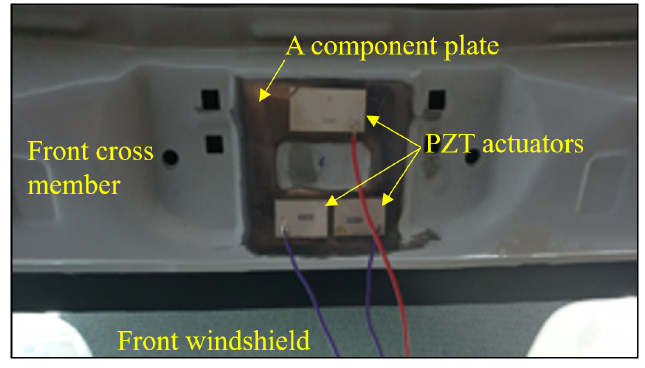
Figure 6. Set-up of the PZT-plate Figure 6. Set ‐ up of the PZT ‐ plate actuator.